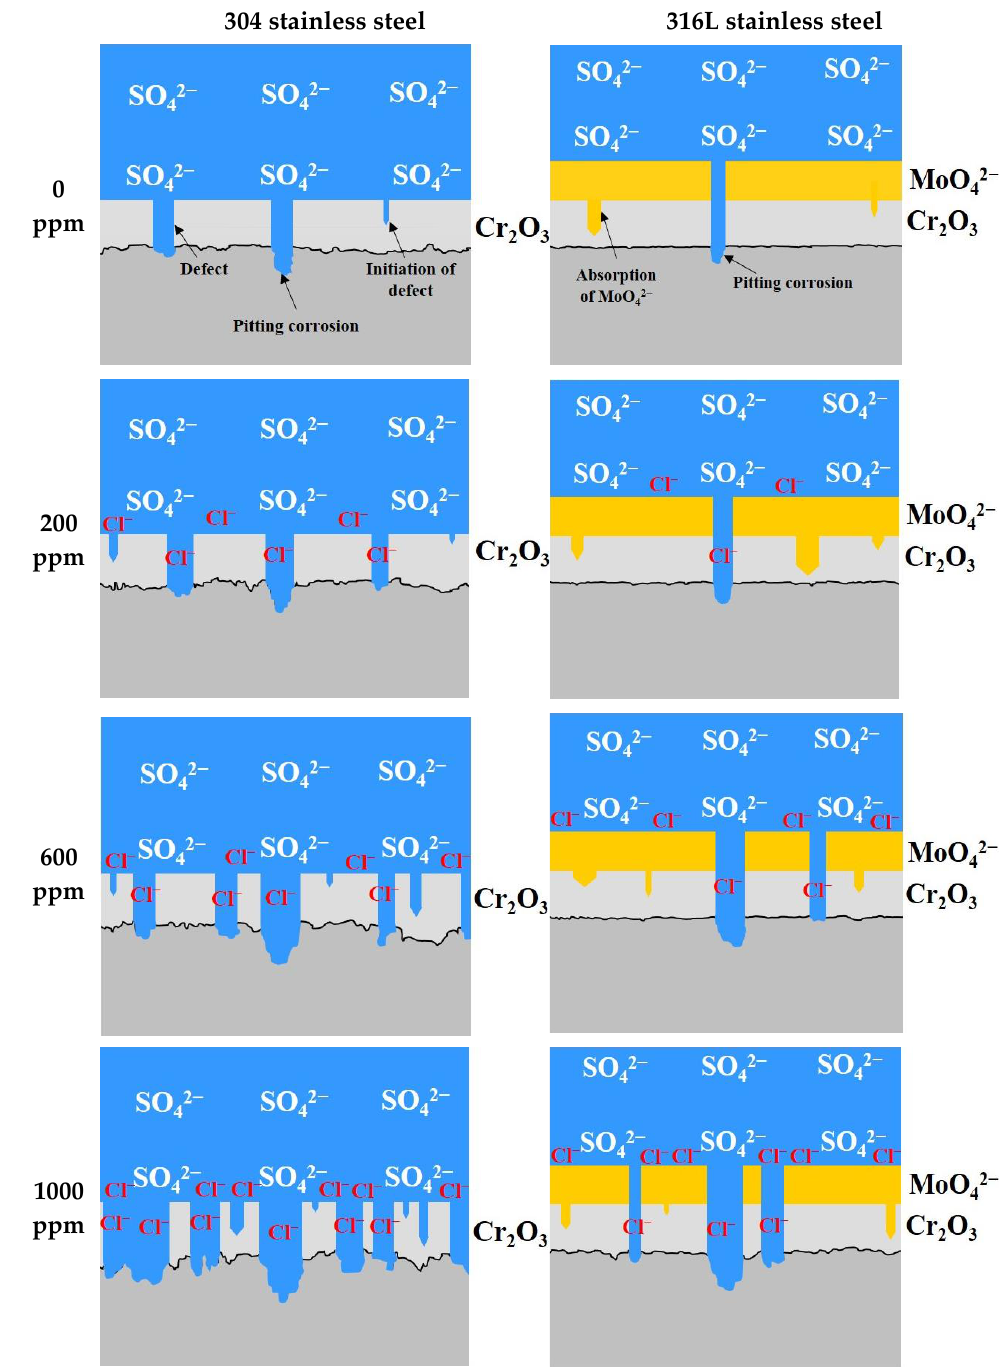
Figure 12. Schematic diagram of damage behavior for 304 and 316L stainless steels after a potentiodynamic polarization experiment.